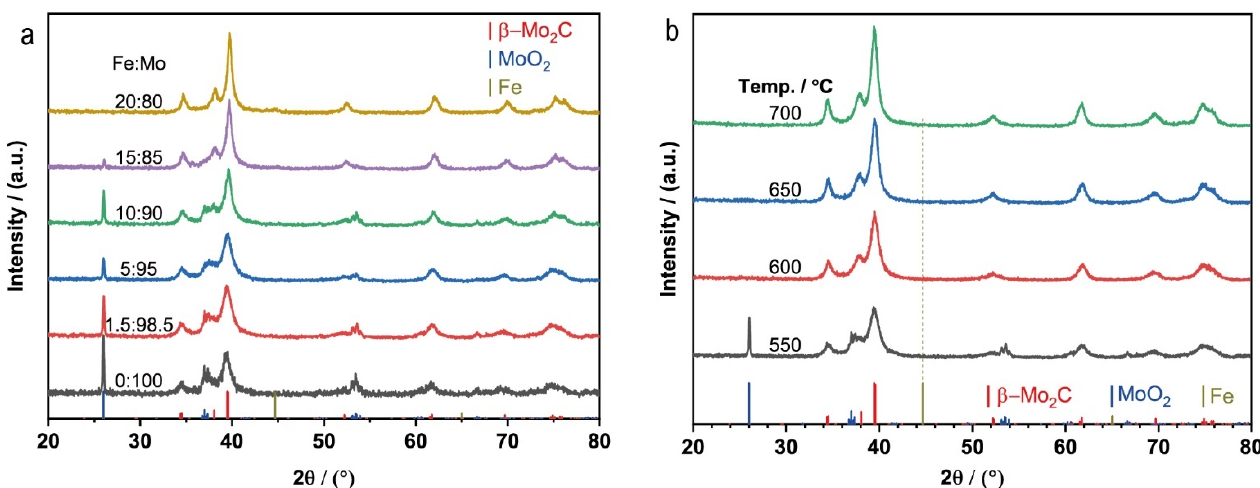
Figure 1. X-ray diffraction (XRD) patterns of Fe-promoted molybdenum carbides (Fe/Mo 2 C-550) ( a ) with different Fe promoting amounts and 1.5Fe/Mo 2 C ( b ) with different final carburization temperatures.